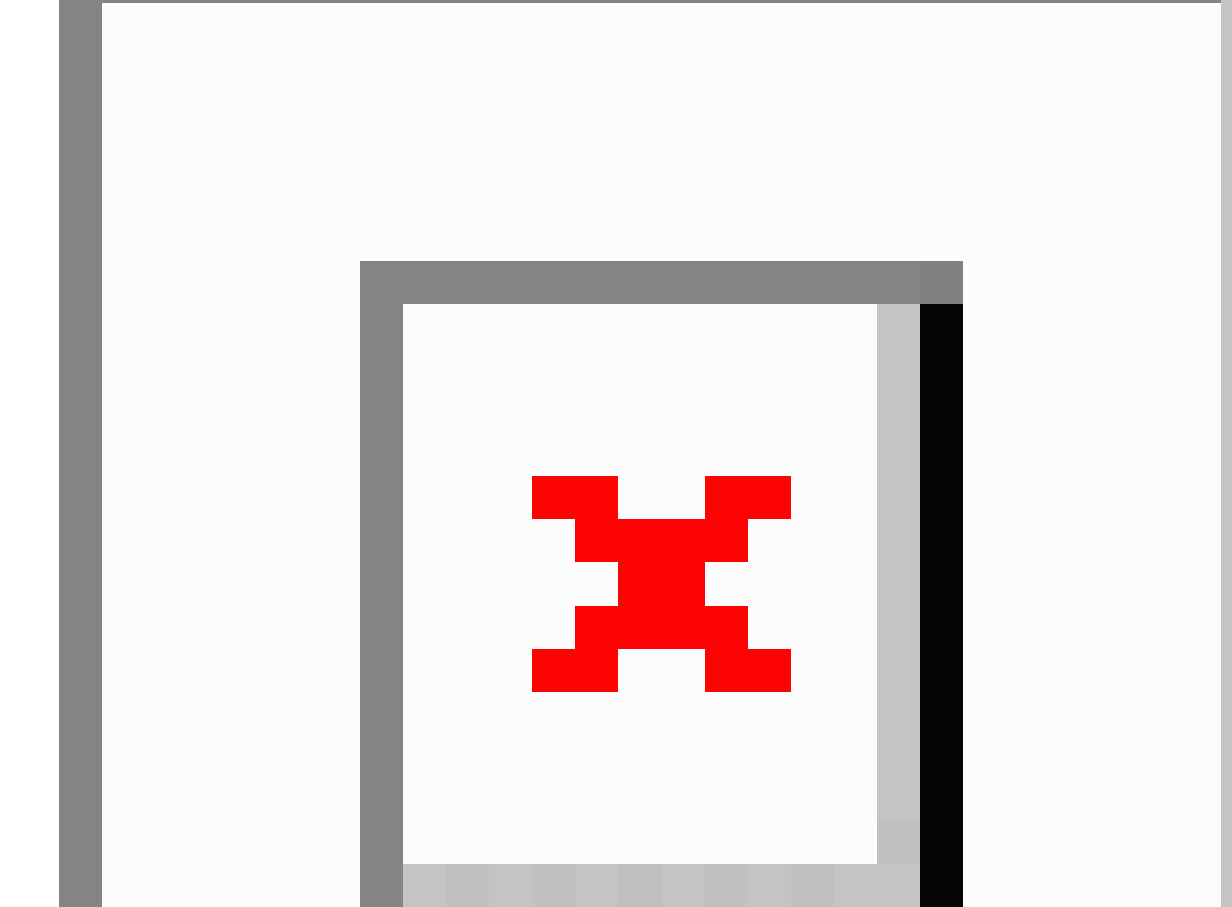
Figure 3. Mean hourly usage of Down Your Drink (Jan to Dec